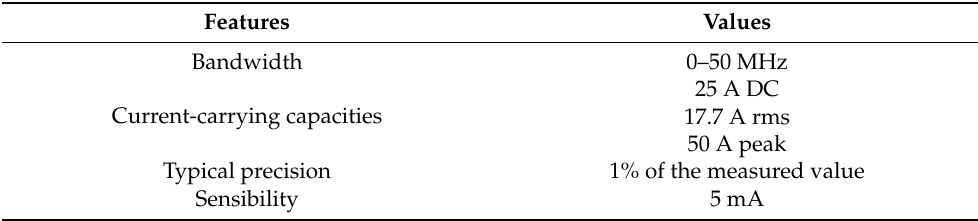
Table 1. Features of the Tektronix TCP (Transmission Control Protocol) 305 current sensor.